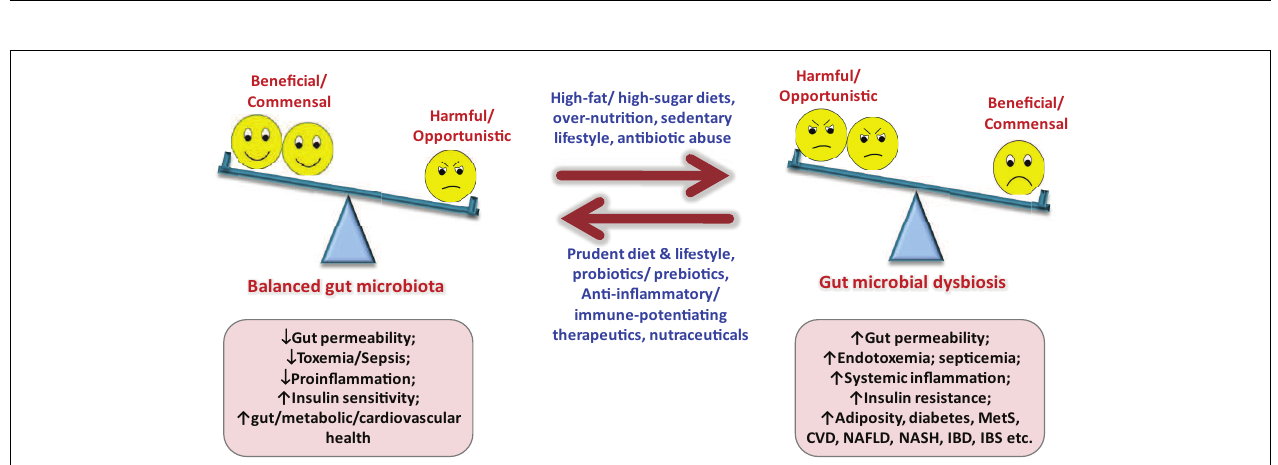
FIGURE 1 | Speculated health implications of gut microbiota . NAFLD, non-alcoholic fatty liver disease; NASH, non-alcoholic steatohepatitis; HS, hepatic steatosis; IBD, inflammatory bowel disease; IBS, irritable bowel syndrome; UC, ulcerative colitis.